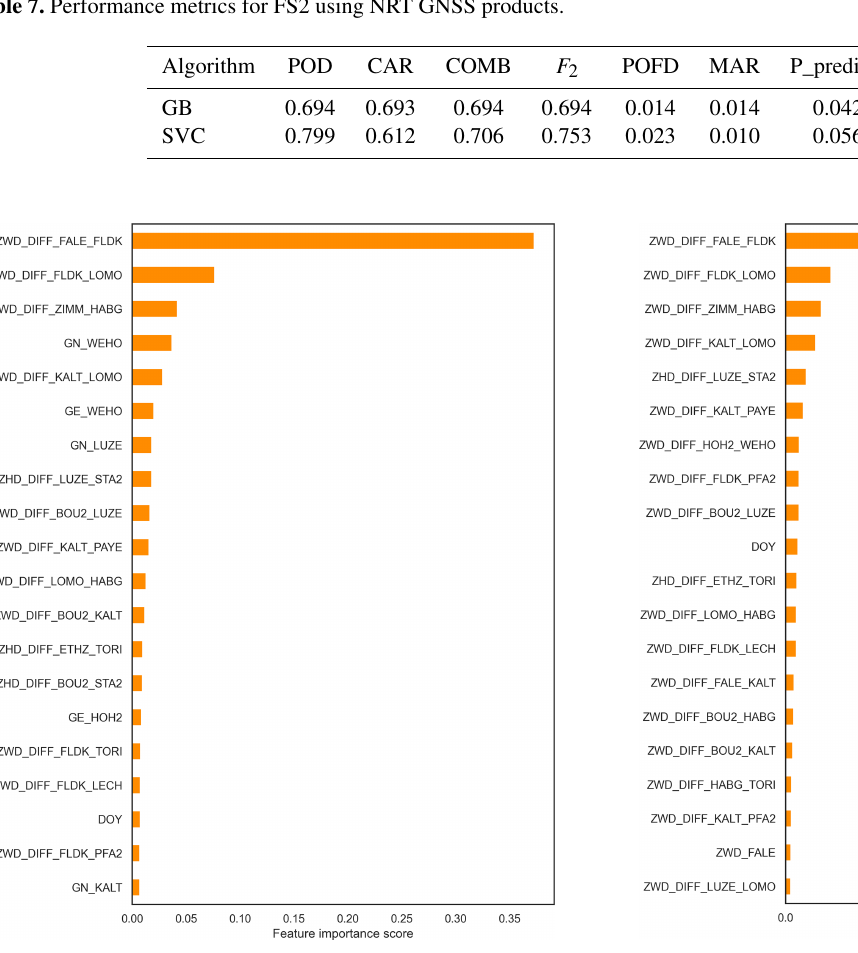
Table 7. Performance metrics for FS2 using NRT GNSS products.